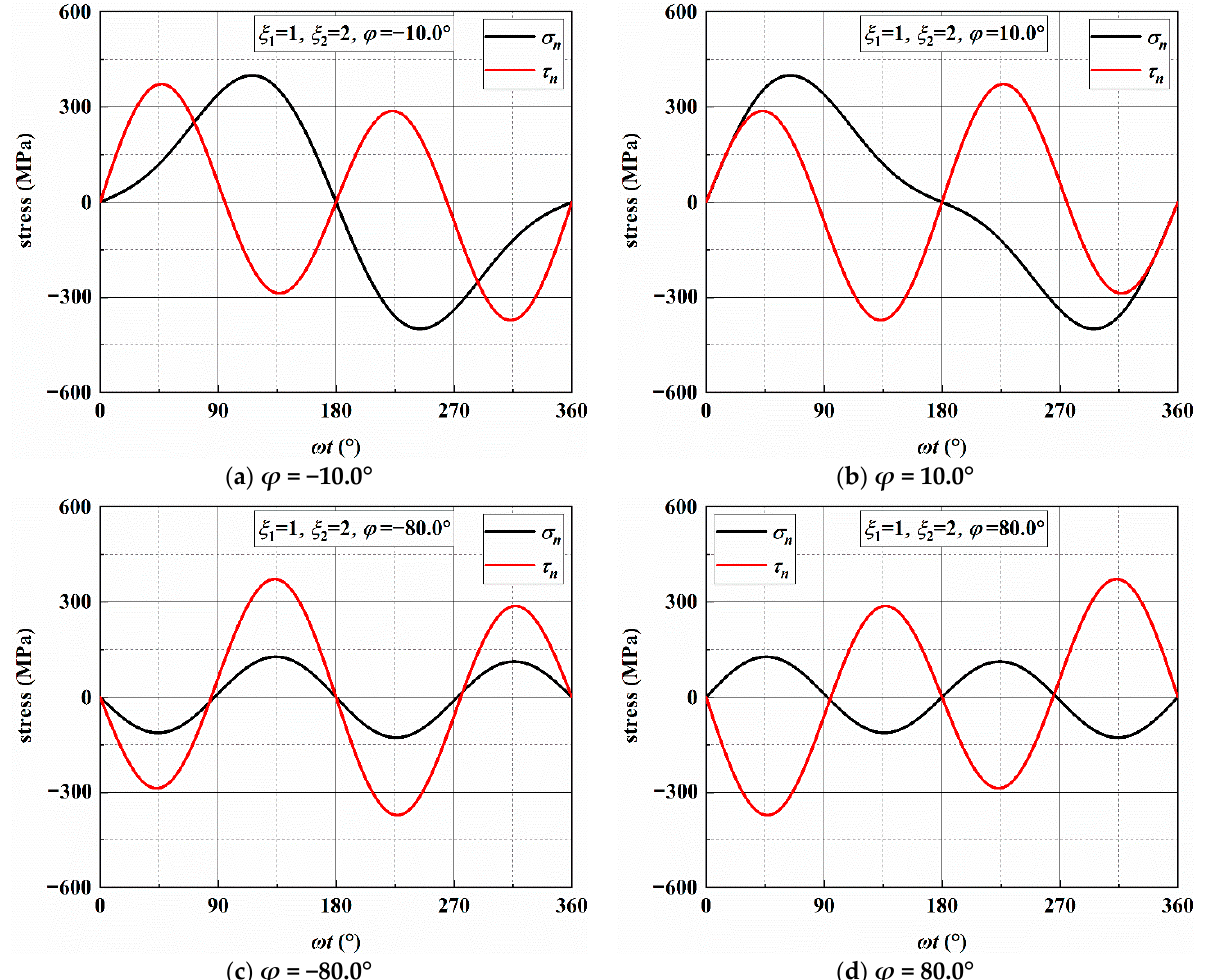
Figure A2. Variation of normal and shear stress on MSSA plane under AS-3.